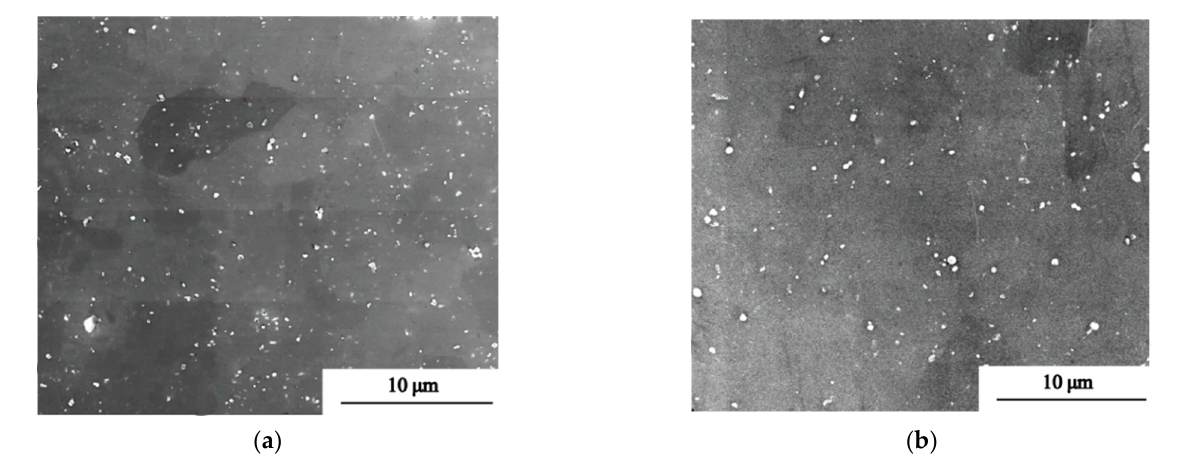
Figure 4. SEM images of ( a ) original plates and ( b ) reprocessed plates.